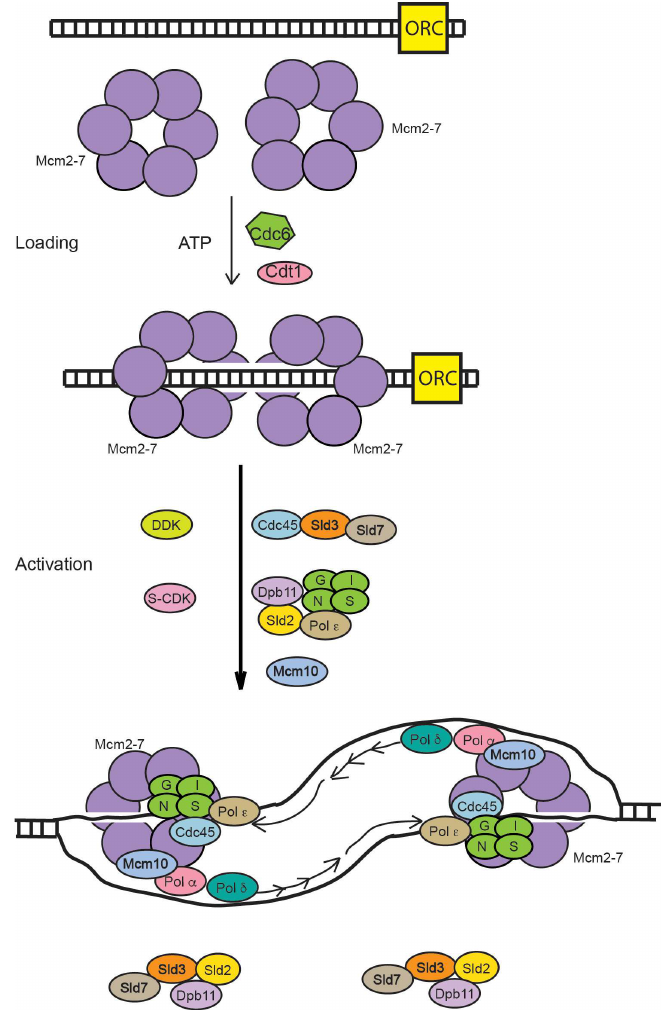
Figure 1. Role of Mcm2-7 in DNA replication. In late M and G1 phases, ORC, Cdc6, and Cdt1 function with ATP to load Mcm2-7 as a double hexameric ring surrounding double-stranded DNA. Mcm2-7 replication initiation proteins (Sld3, Sld2, Dpb11, Sld7, Pol ε, and Mcm10) to assemble Mcm2-7